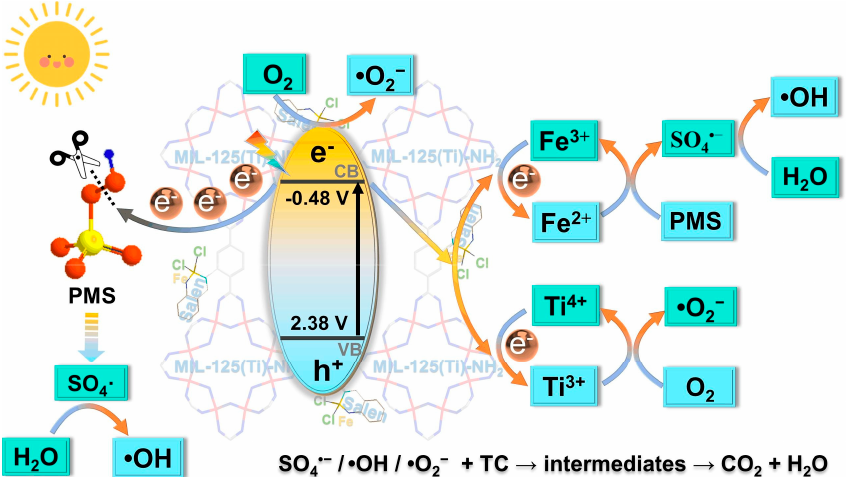
Figure 11. Mechanism for TC degradation by MSF/PMS/light system. Adapted with permission from Ref. [79], 2023, Elsevier.